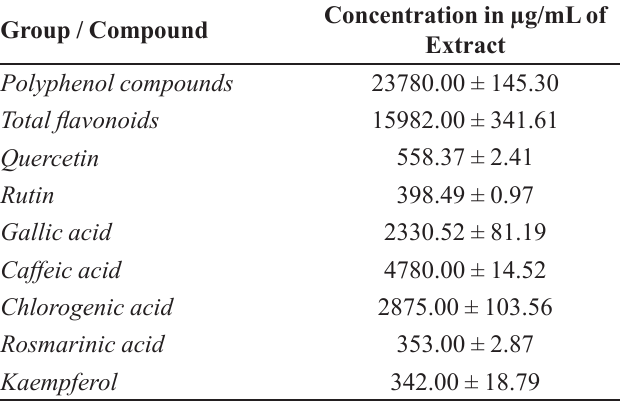
TABLE I - Concentrations of some biologically important groups and compounds presents in the samples used of O. basilicum L